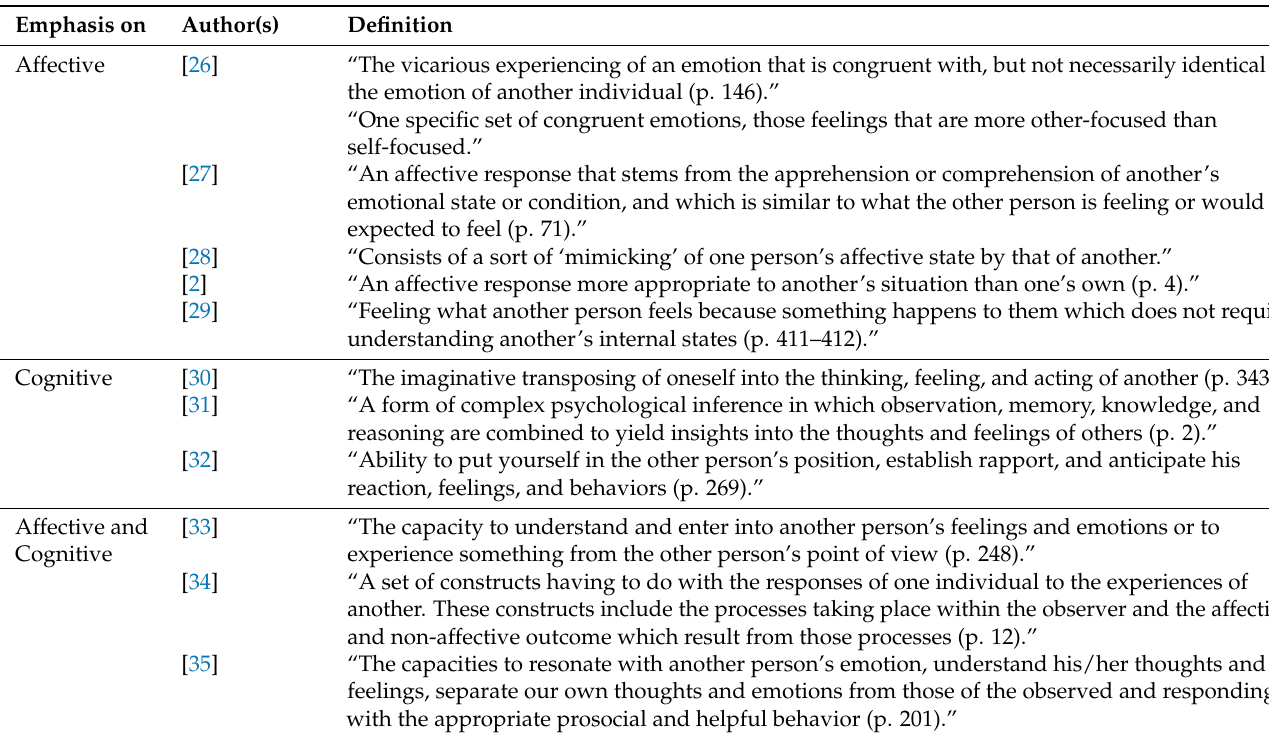
Table 2. Definitions of